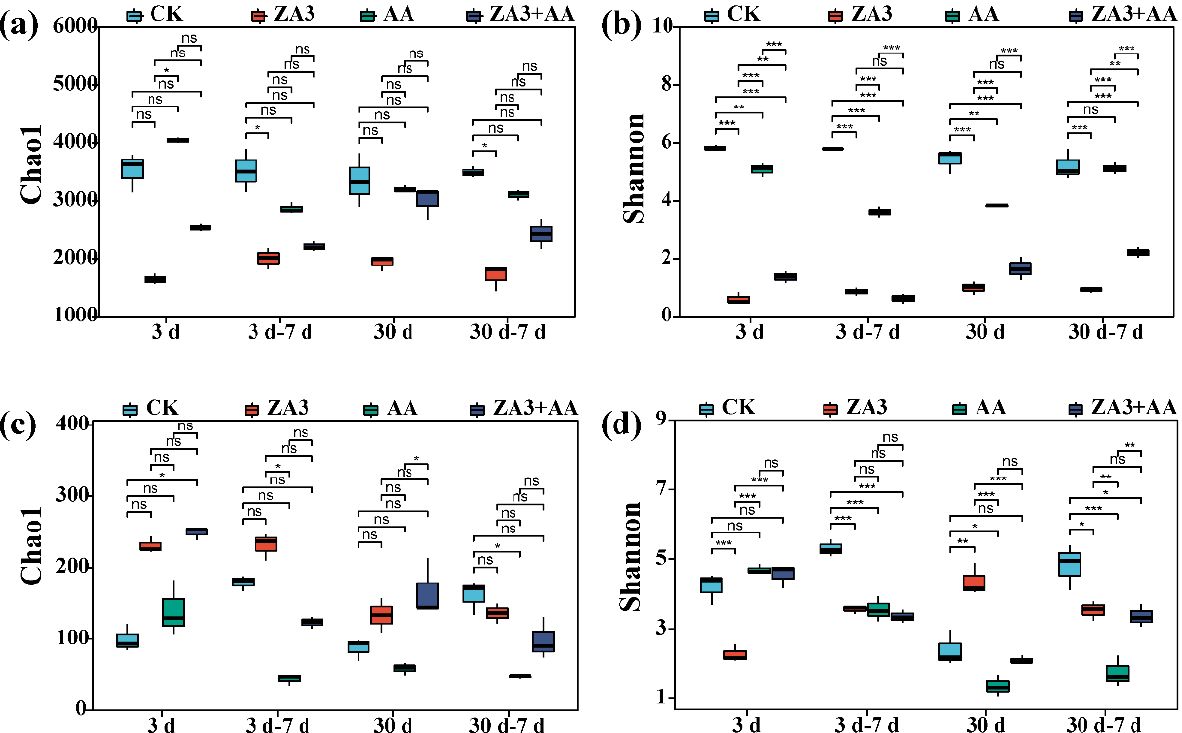
Figure 5. Alpha diversity of bacteria and fungi of FSBM during fermentation and aerobic exposure. ( a , b ), Chao1 and Shannon indices of bacterial communities; ( c , d ), Chao1 and Shannon indices of fungi communities. ns, no significance. *, p < 0.05; **, p < 0.01; ***, p < 0.001. d, days.